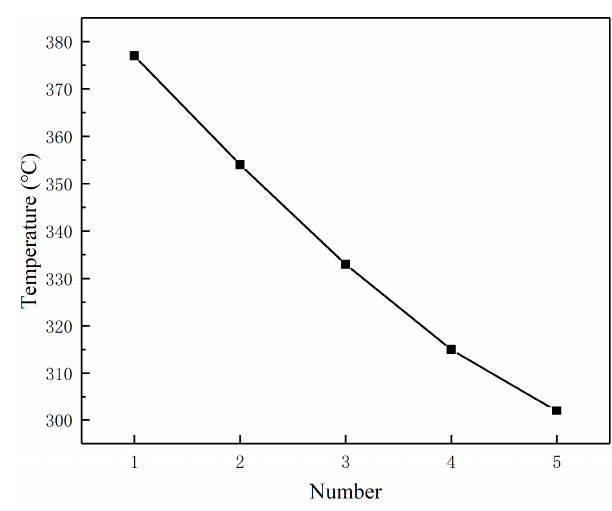
Figure 18. Weld bottom temperature curve.